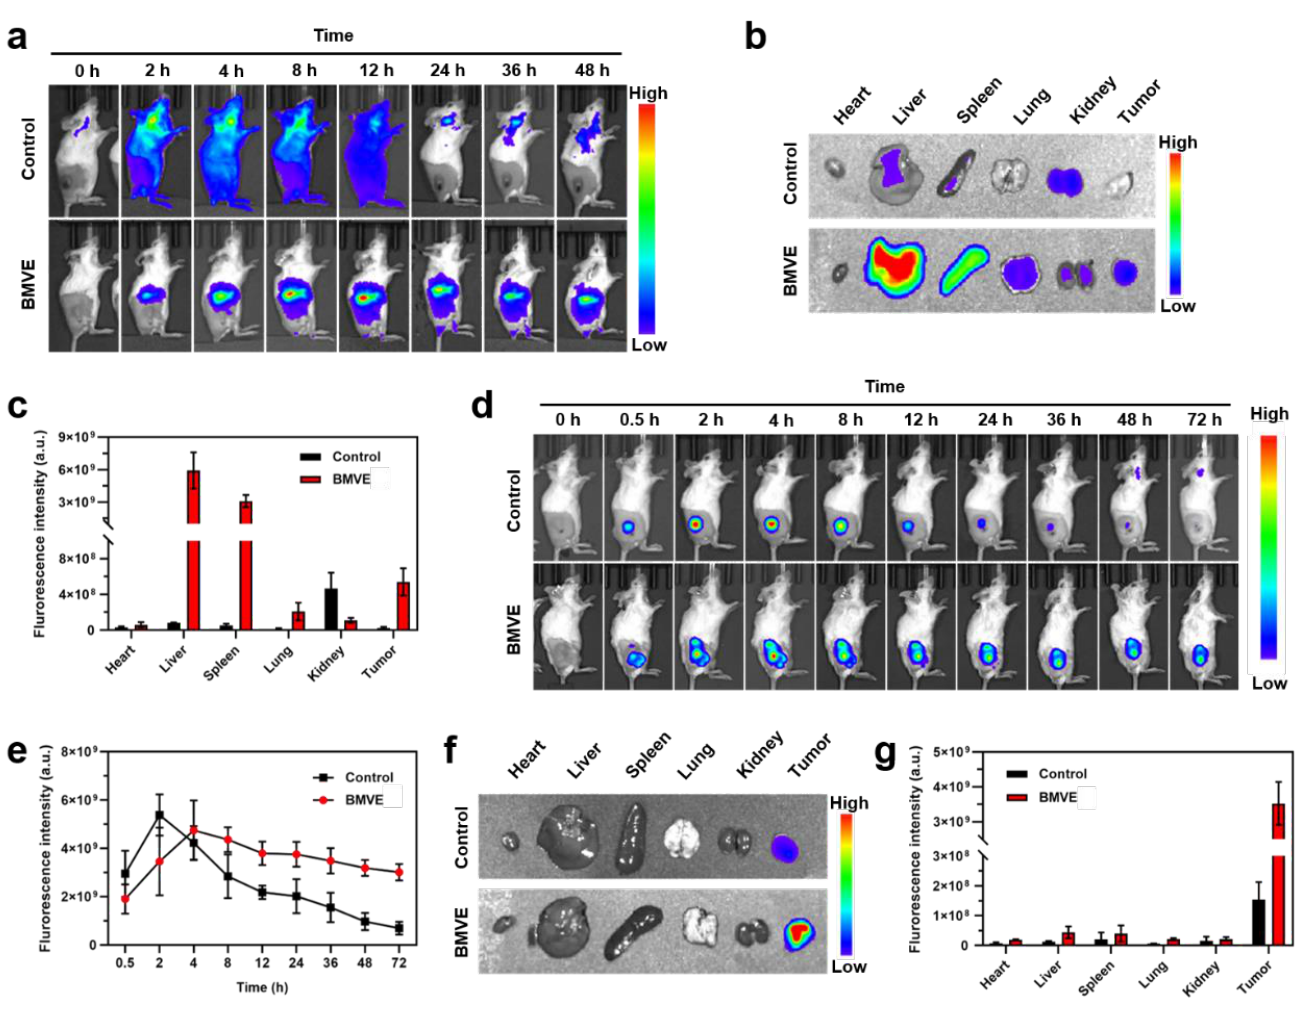
Figure 5. BMVE biodistribution in mice. ( a ) DiR dye (control) or DiR-labeled BMVE was injected through the tail vein of mice, and fluorescence imaging was performed at different time points to observe the distribution of BMVE in vivo. ( b ) The mice were sacrificed and dissected at 48 h, and the main organs (i.e., heart, liver, spleen, lung and kidney) and tumor were used for fluorescence imaging. ( c ) Fluorescence intensity statistics in the major organs and tumor at 48 h. ( d ) Intratumoral injection of DiR dye (control) or DiR-labeled BMVE was performed in mice, and fluorescence imaging was performed at various time points to observe BMVE distribution in vivo. ( e ) Fluorescence intensity statistics in tumors at various time points. ( f ) The control and BMVE group mice were sacrificed and dissected at 72 h, and their main organs (i.e., heart, liver, spleen, lung and kidney) and tumor were observed via fluorescence imaging. ( g ) Fluorescence intensity statistics in the major organs and tumor at 72 h.